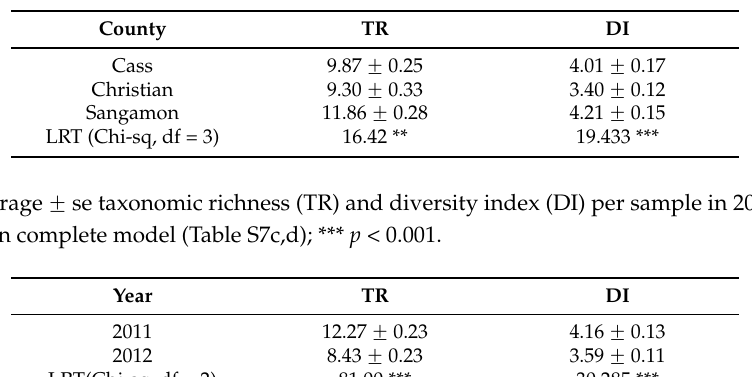
Table 5. Average ± se taxonomic richness (TR) and diversity index (DI) per sample in Sangamon ( n = 298), Cass ( n = 298), and Christian Counties ( n = 294). LRT based on complete model (Table S7a,b); ** p < 0.01; *** p < 0.001.